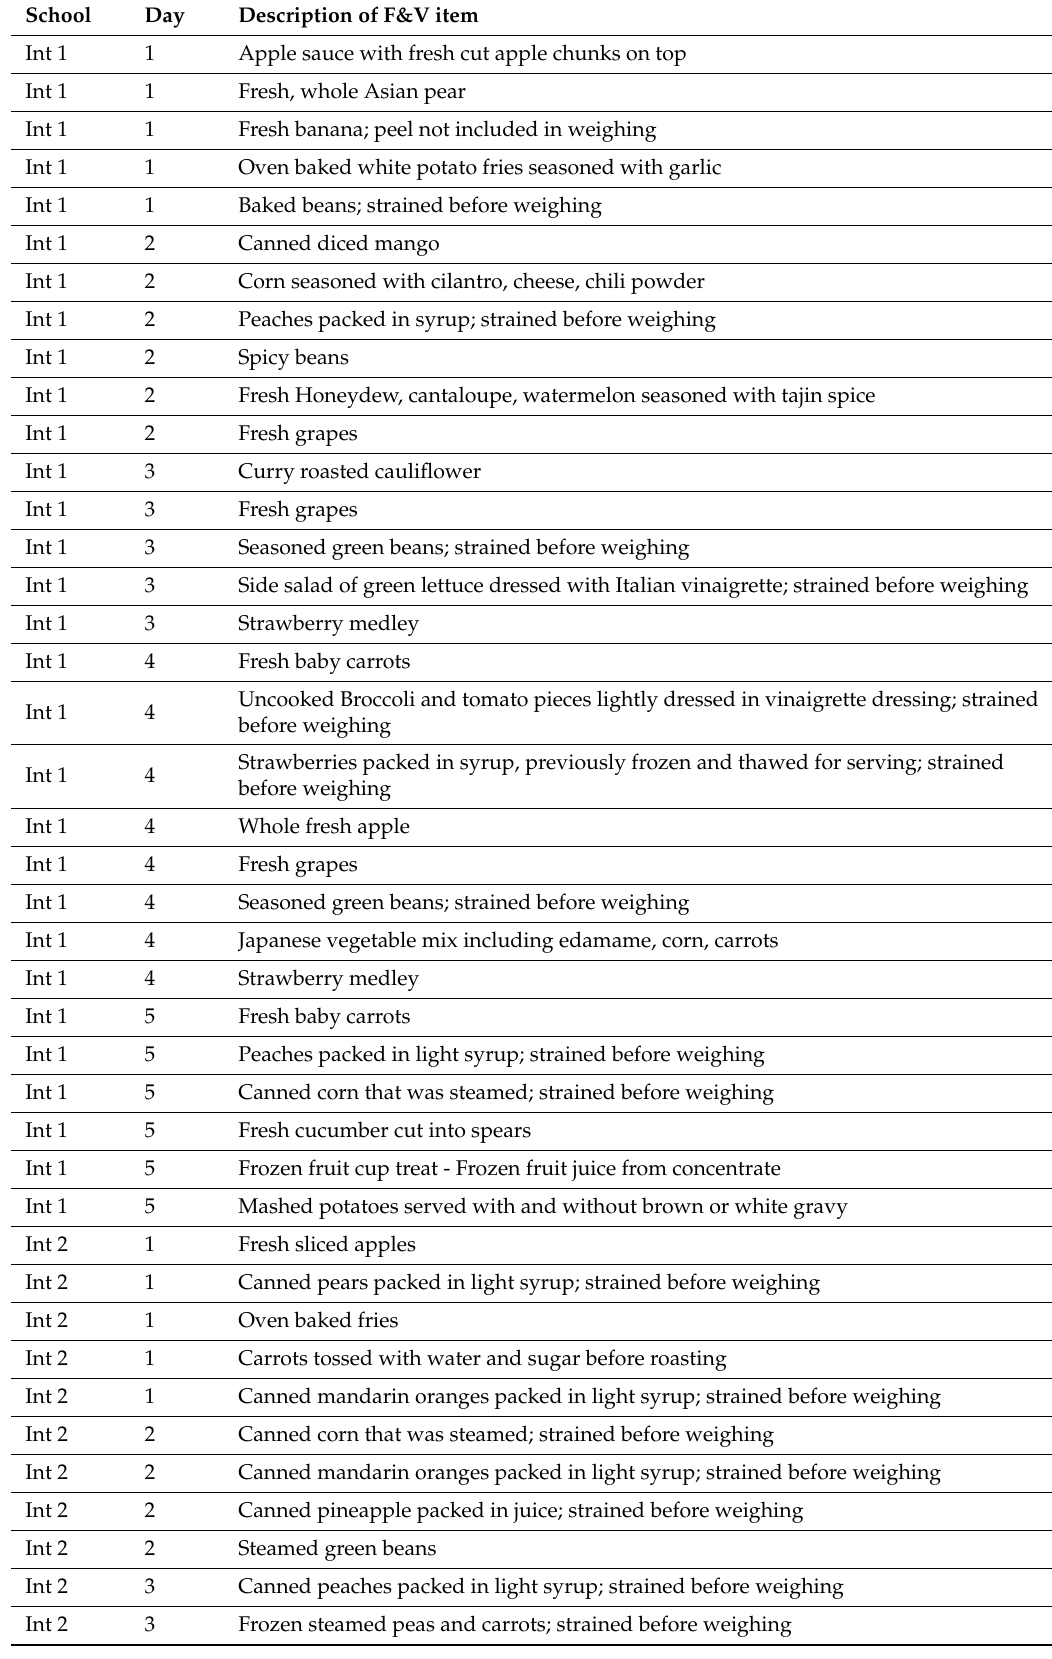
Table 4. Fruit and Vegetable Items Served at